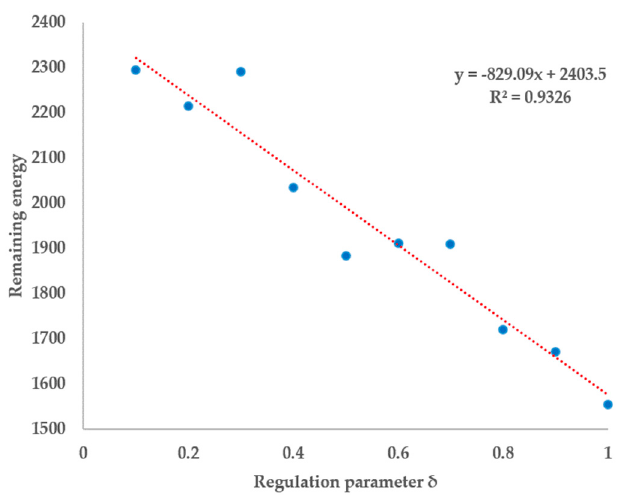
Figure 13. Influences of δ on energy remained.